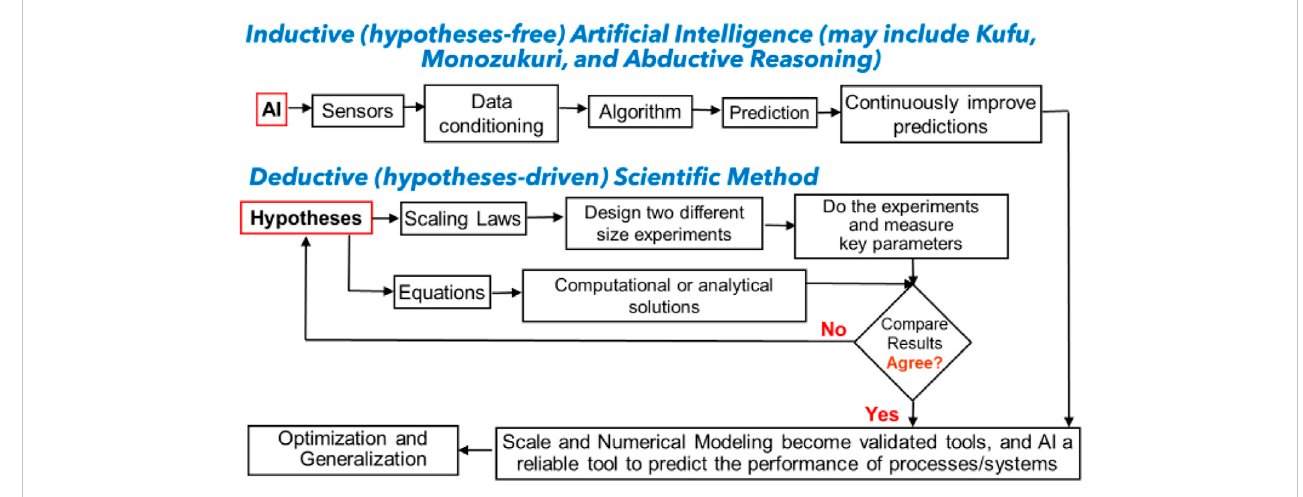
FIGURE 4 The deductive hypotheses-driven scale and numerical modeling, and inductive hypotheses-free arti fi cial intelligence (Saito,